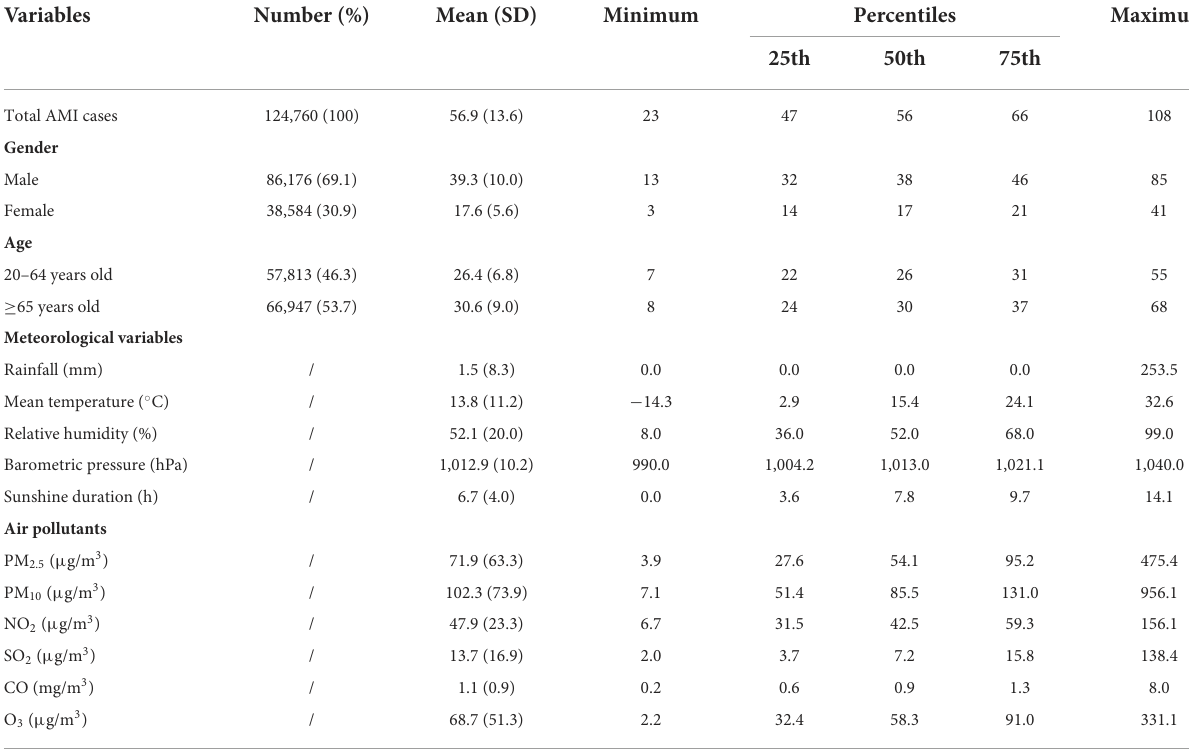
TABLE 1 Descriptive statistics of daily AMI hospitalizations, weather conditions, and air pollution in Beijing, China during 2013–2018.